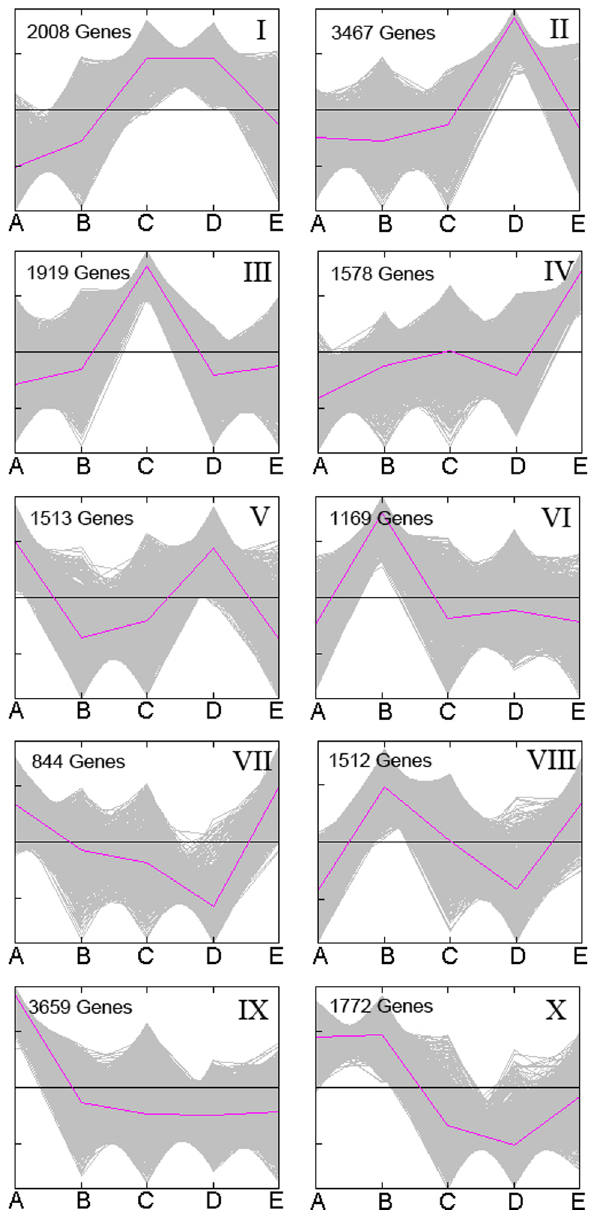
Figure 3. Dynamic expression patterns during broccoli seed germination and sprout development. K-means clustering was performed to identify 10 clusters, each containing various numbers of genes with similar expression pattern during broccoli seed germination and sprout development. The red lines show representative transcrip- tional regulators. The x-axis represents sequenced samples, and the y- axis represents normalized RNA-seq expression level. A. seeds; B. 3 day cotyledons; C. 7 day cotyledons; D. 11 day cotyledons; E. 11 day euphyllas.